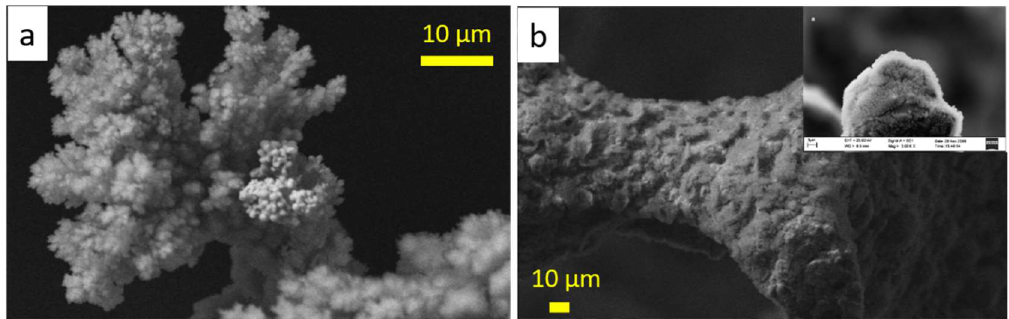
Figure 6. SEM images of Rh/Mg/Al coating on FeCrAlloy foam electrodeposited at −1.2 V vs. SCE in 0.03 M Rh/Mg/Al = 11/70/19 a.r.% and 0.3 M KNO 3 at different synthesis conditions: ( a ) 1000 s and pH 2.1 (without adjusting the pH), ( b ) 1000 s and pH 3.8. The pH was adjusted by NaOH. Adapted from [61].